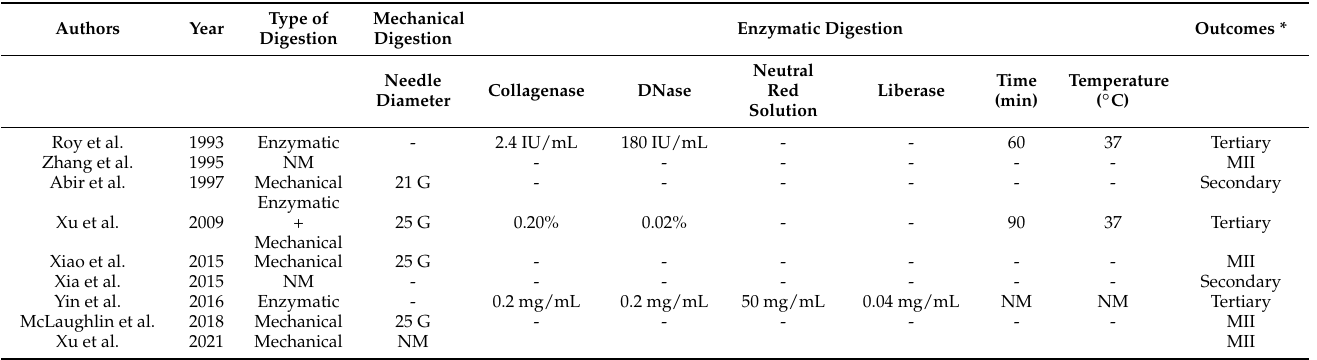
Table 4. Studies reporting isolation of secondary follicle in order to carry out the second step of folliculogenesis (from secondary follicle to antral follicle